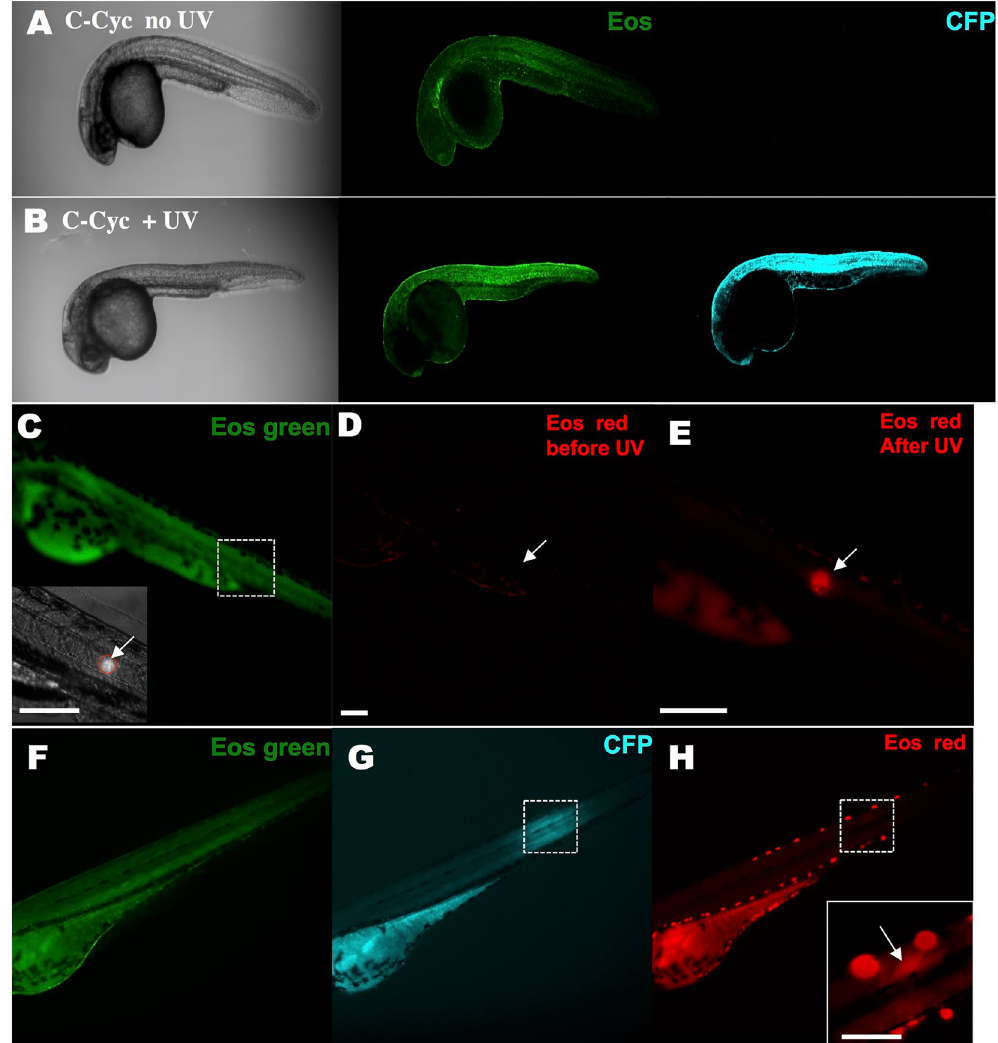
Figure 5. KRASG12V activation and tracking in a small group of cells within a live zebrafish embryo. A stable Tg(ubi:Eos;UAS:kRASG12V-T2A-CFP) line was generated and crossed with the Tg(ubi:Gal4-ERT2) line. Caged cyclofen alone at 1 dpf was not able to induce CFP expression ( A ), while 2-minute UV illumination ( B ) effectively turned on CFP after 18 hours. ( C ) Local activation of kRASG12V expression was achieved by introducing a focalized UV beam onto embryos pre-incubated with caged cyclofen. ( D , E ) 1 minute UV effectively converted EosFP from green to red. ( F , G ) After 18 hours, CFP expressed in a localized region of the illuminated embryo and weak remaining EosFP red signal was detected in the same region ( H ). Scale bar: 200 μ